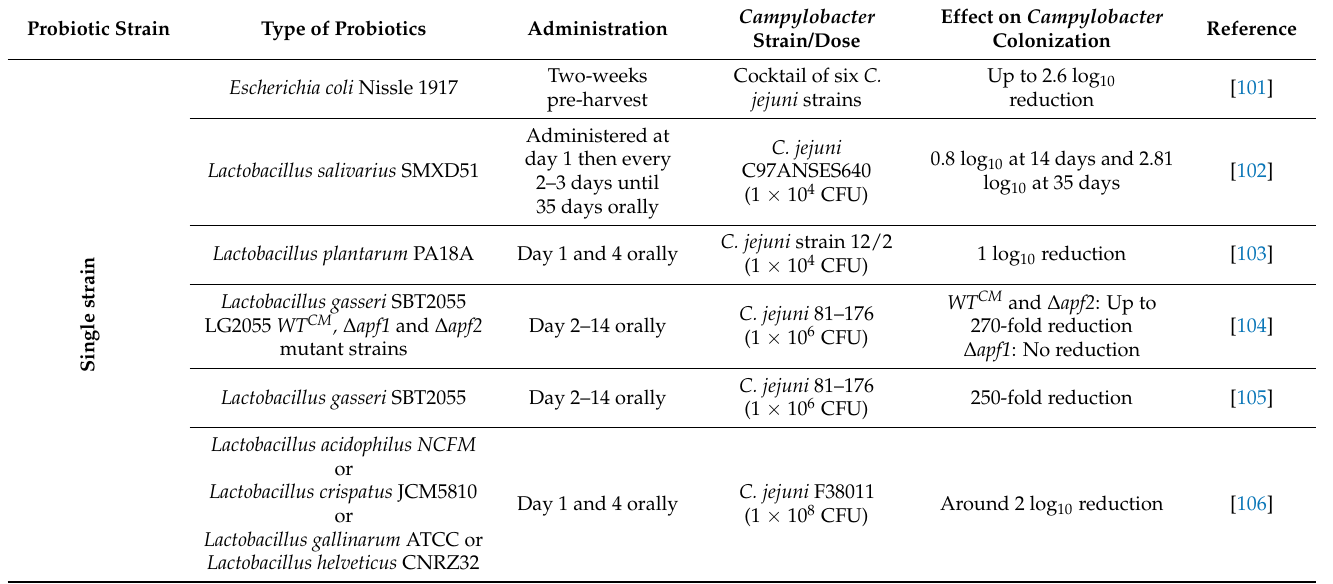
Table 2. Probiotics used to treat Campylobacter infections in chickens (modified from [100]). Probiotic Strain Type of